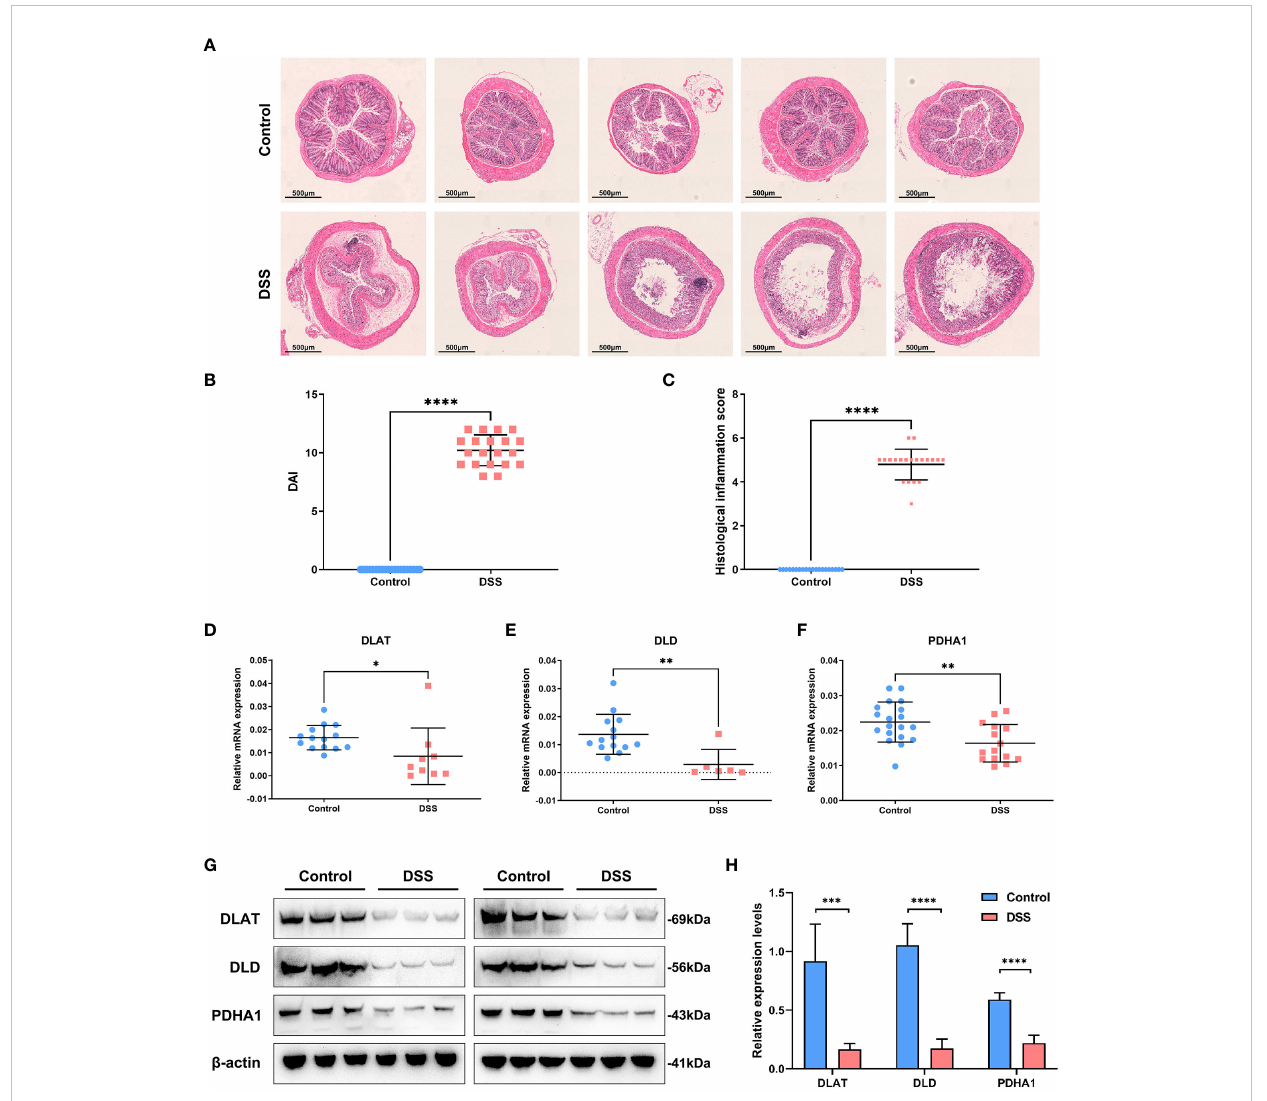
FIGURE 7 Experimental veri fi cation in the UC mouse model. (A) Hematoxylin and eosin-stained sections depicting mouse colonic mucosa in the control and DSS groups. (B) DAI scores increased after acute administration of DSS. (C) Histological in fl ammation scores increased after DSS treatment. (D – F) The expression levels of DLAT , DLD , and PDHA1 were detected by using real-time quantitative polymerase chain reaction. (G, H) The expression levels of DLAT , DLD , and PDHA1 were detected by Western blot analysis in the UC mouse model. (*p < 0.05; **p < 0.01; ***p < 0.001;****p <